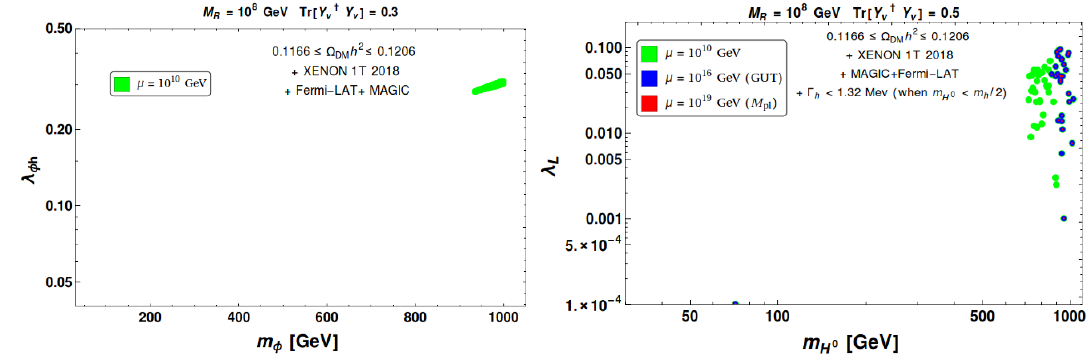
Figure 32 . Parameter space scan for (left) scalar singlet DM and (right) IDM cosnidering satis- faction of relic density bound, direct detection cross section limit, indirect cross-section limit and high scale validity in presence of RH